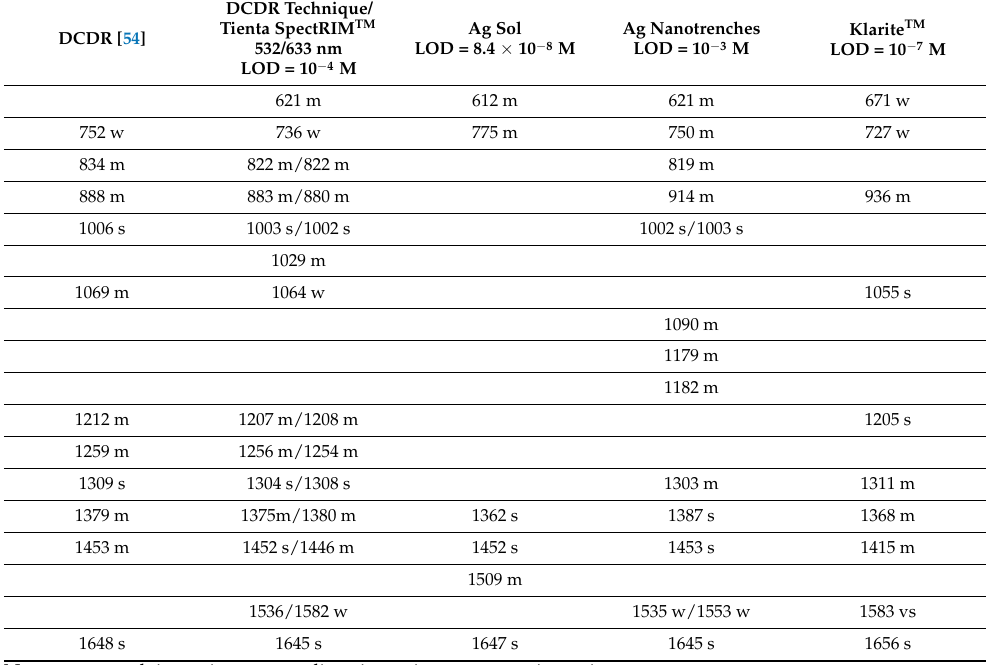
Table 2. Relevant Raman marker bands detected by using DCDR technique compared to those re- ported in [54] and SERS marker bands recorded by using the SERS platforms Ag sol, Ag nanotranches and Klarite TM . The limits of detection (LOD) for all three nanoplatforms are also indicated. NOD marker bands are highlighted in